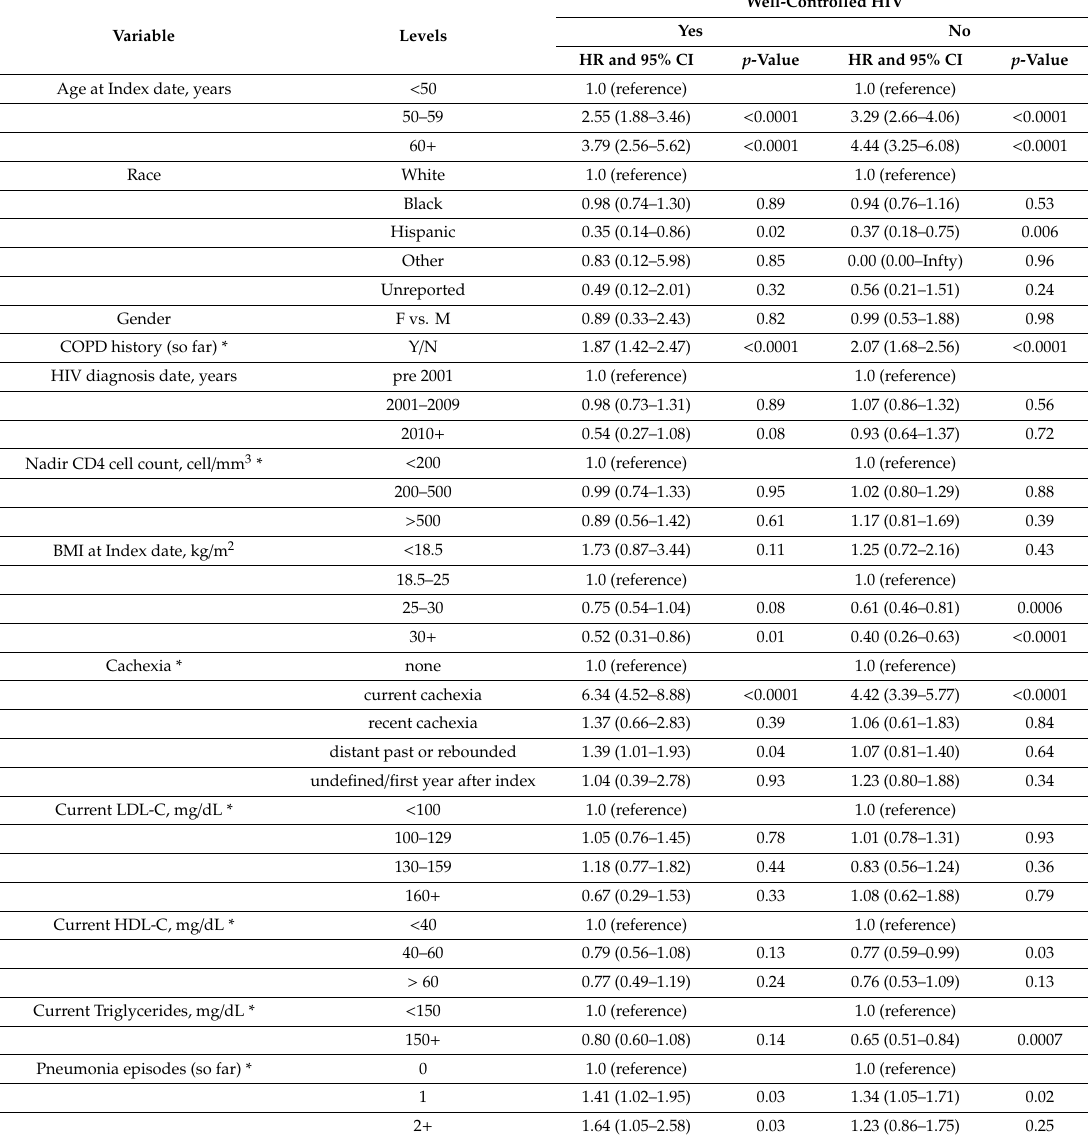
Table 3. Multivariable hazard ratios and 95% confidence intervals for the association between HIV-infection and risk of NSCLC in PWH with a history of smoking according to agree of HIV viral